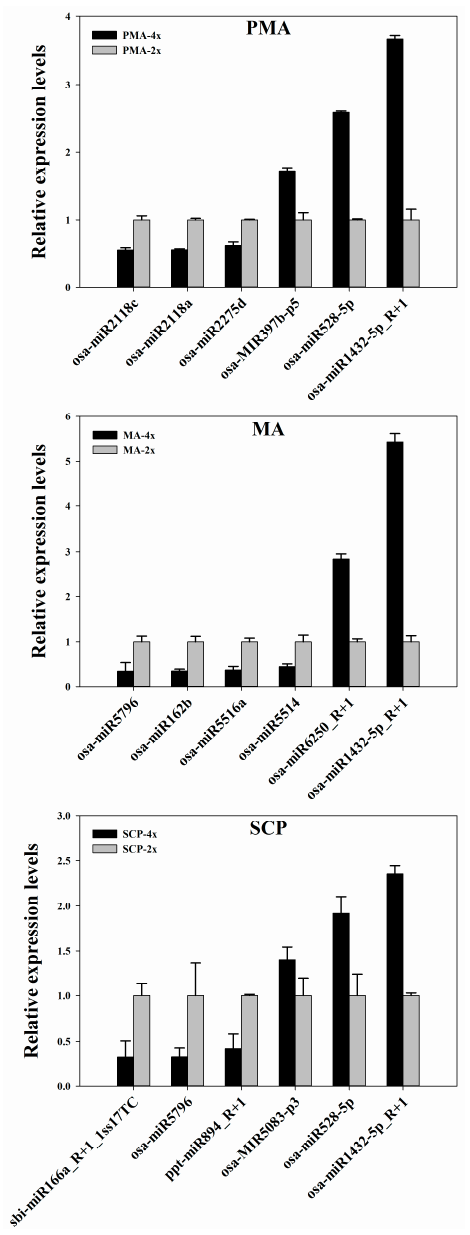
Figure 1. Validation of the DEM (differentially expressed miRNAs) in autotetraploid and diploid rice at each pollen development stage (pre-meiotic interphase (PMA), meiosis (MA) and single microspore stage (SCP)). U6 snRNA was used as an internal reference for the qRT-PCR. The x - and y -axis represent the miRNAs and relative expression levels, respectively. Error bars represent the standard deviation (SD) of three biological replicates. “4x” and “2x” represent the autotetraploid and diploid rice, respectively.